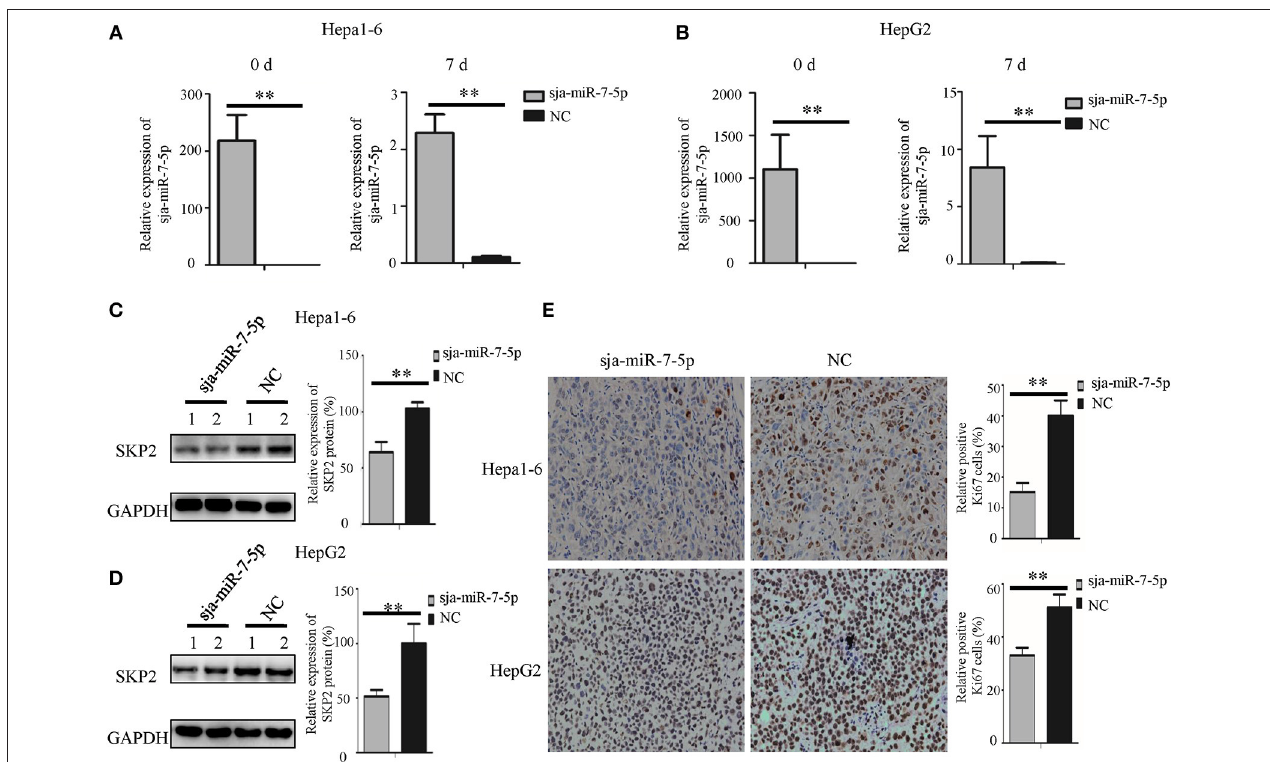
FIGURE 6 | Sja-miR-7-5p inhibits the expression of SKP2 and Ki67 within hepatoma cell tumors. (A,B) The content of sja-miR-7-5p mimics after transfection into tumor cells was measured using qRT-PCR before inoculation (0 d) and after sacrifice (7 d), with U6 as the internal control, (A) for Hepa1-6 cells, (B) for HepG2 cells. Data are presented as the mean ± SD, n = 5, ** p < 0.01. (C,D) The protein level of SKP2 was determined by Western blotting, with glyceraldehyde-3-phosphate (GAPDH) as the internal control, (C) for Hepa1-6 cells, (D) for HepG2 cells. (E) The level of Ki67 in tumors was determined using immunohistochemistry.